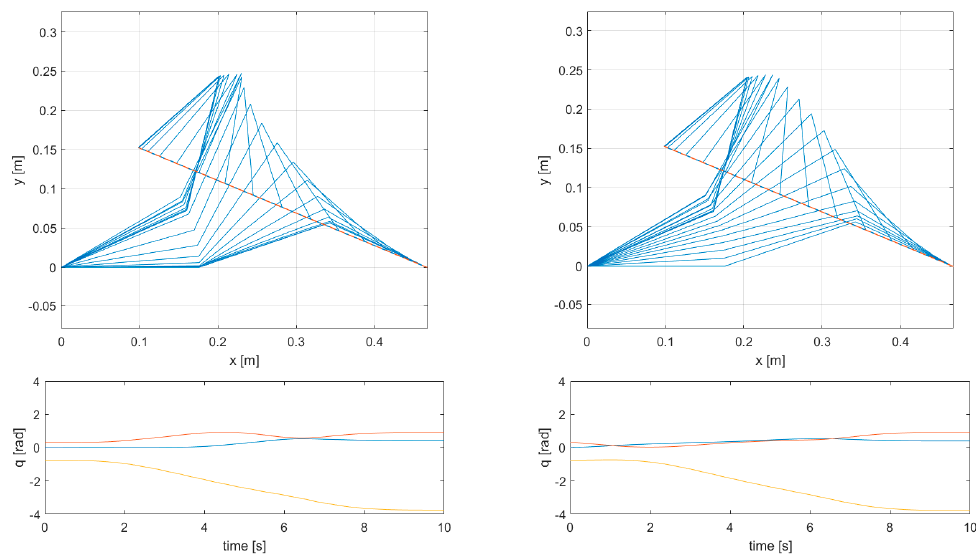
Figure 11. Trajectory 3, comparison between PMKE ( left ) and global optimal solution ( right ). First joint: blue lines; second joint: red lines; third joint: yellow lines.